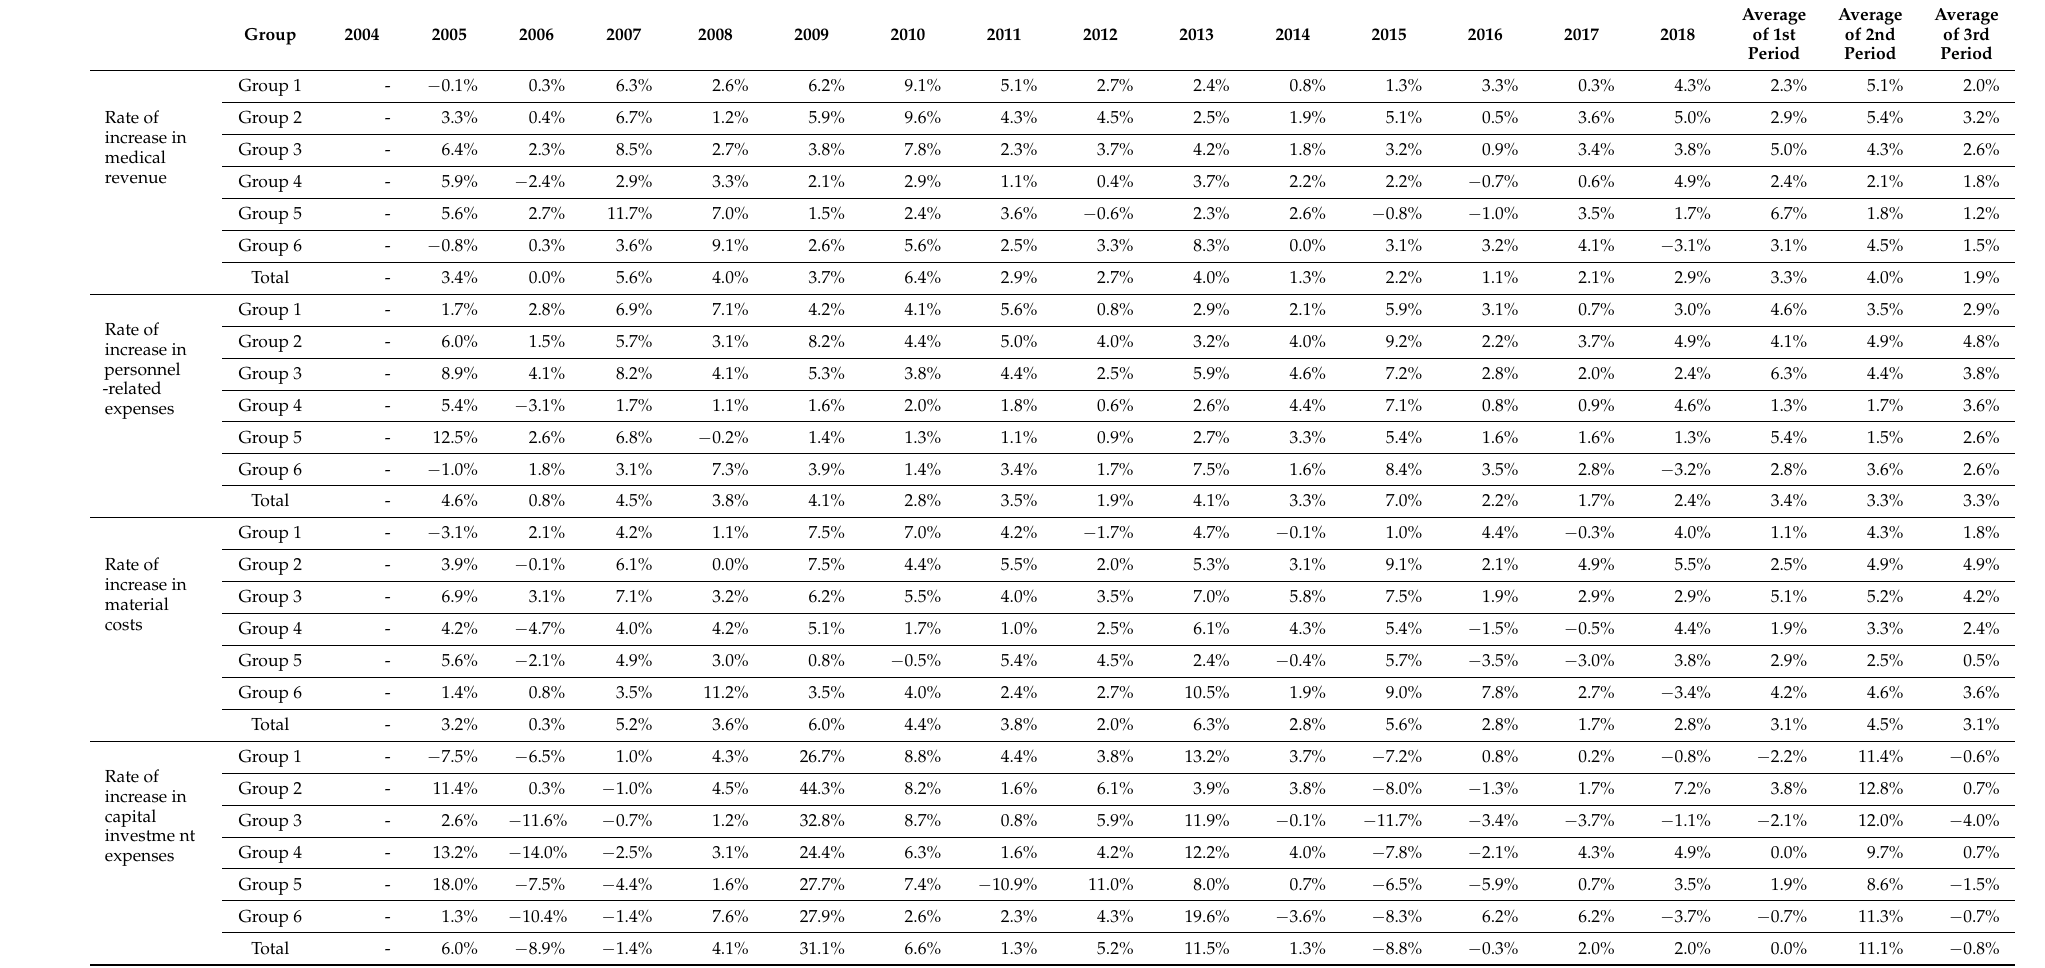
Table 3. Management indicators in the 15 years of the